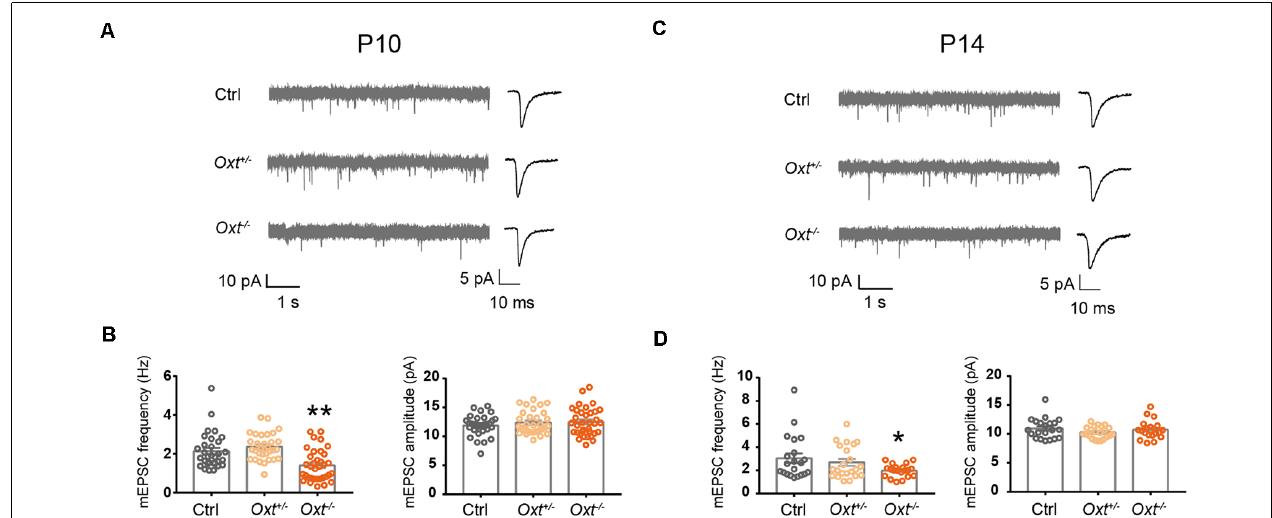
FIGURE 5 | Reduced excitatory synaptic transmission in oxytocin knockout mice. (A–C) Representative mEPSC recording (left) and average waveforms (right) of Oxt +/- , Oxt -/- mice and littermate Ctrl mice at P10 and P14. (B) mEPSC frequency is reduced in P10 Oxt -/- mice (Ctrl, 2.13 ± 0.17 Hz; n = 31; Oxt + / − , 2.36 ± 0.12 Hz; n = 31; Oxt -/- , 1.40 ± 0.14 Hz; n = 35; P < 0.01 vs. Ctrl), while mEPSC amplitude is not significantly affected (Ctrl, 11.88 ± 0.32 pA; Oxt + / − , 12.39 ± 0.35 pA; Oxt -/- , 12.48 ± 0.41 pA). (D) mEPSC frequency is reduced in P14 Oxt -/- mice (Ctrl, 3.06 ± 0.42 Hz; n = 21; Oxt + / − , 2.69 ± 0.30 Hz; n = 22; Oxt -/- , 1.98 ± 0.12 Hz; n = 20; P < 0.05 vs. Ctrl), while mEPSC amplitude is not significantly affected (Ctrl, 10.95 ± 0.38 pA; Oxt + / − , 10.25 ± 0.22 pA; Oxt -/- , 10.74 ± 0.35 pA). One-way ANOVA followed by Tukey’s multiple comparison test for all panels. * P < 0.05, ** P < 0.01, unpaired t